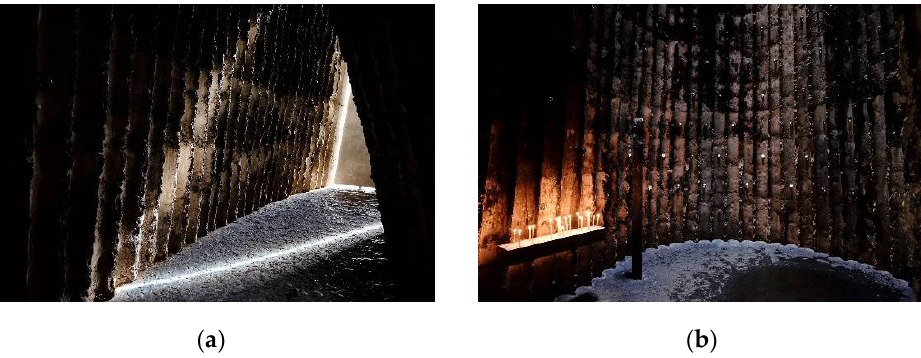
Figure 2. Peter Zumthor, Bruder Klaus Field Chapel, 2007. ( a ) entrance area ( b ) interior space (Photos: August Fischer).